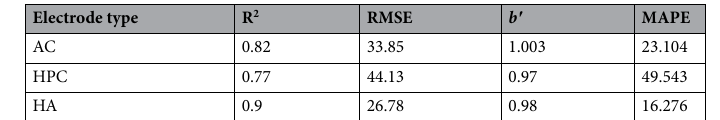
Table 3. Performance analysis of the trained XGBoost models to relate the physicochemical features of carbon electrodes with different structures and the measured specific capacitance.